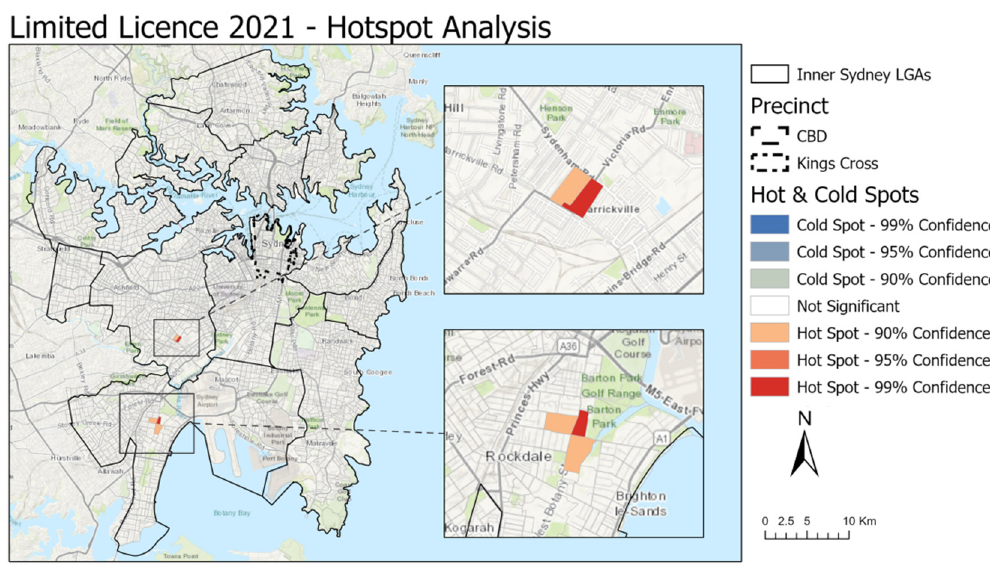
Figure 12. Limited licence hotspots 2021.